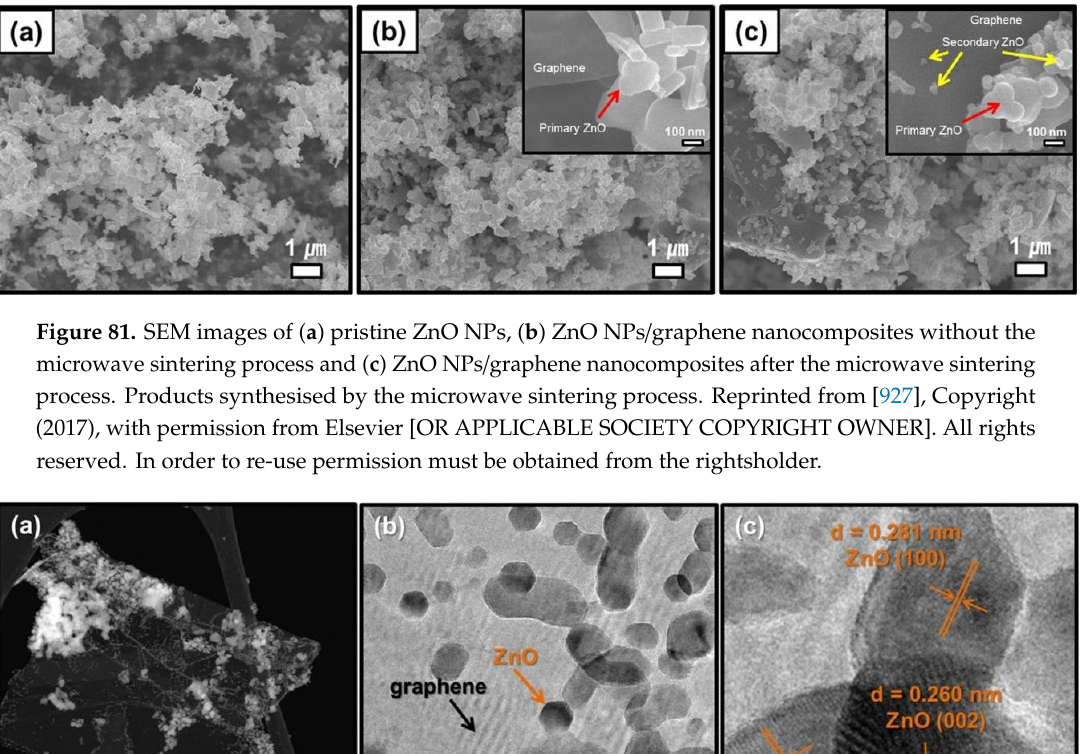
Figure 80. Schematic illustration of different steps of the microwave sintering synthesis of ZnO